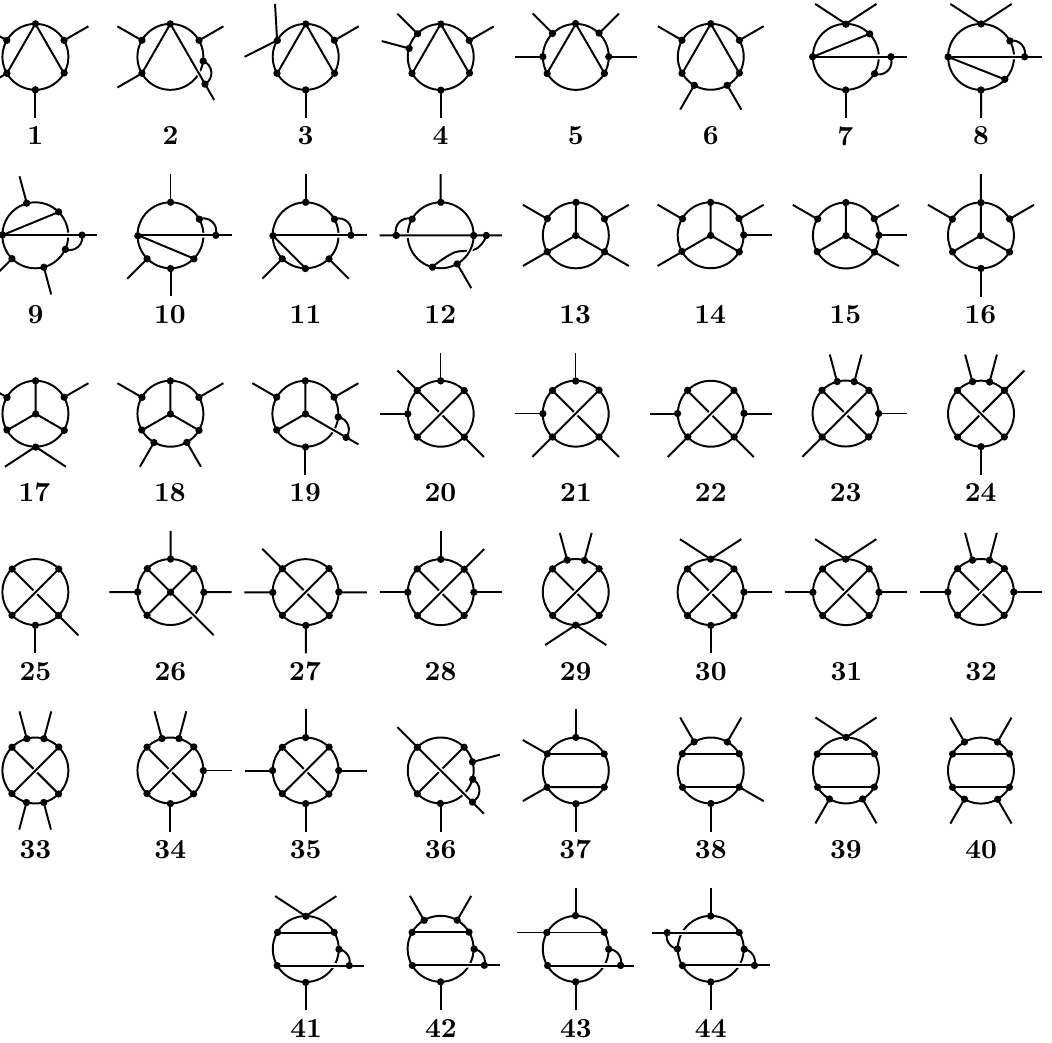
Figure 14 . List of topologies associated to normal genuine diagrams. We refer to them in the text as T i with i = 1 ; (cid:1) (cid:1) (cid:1) ;